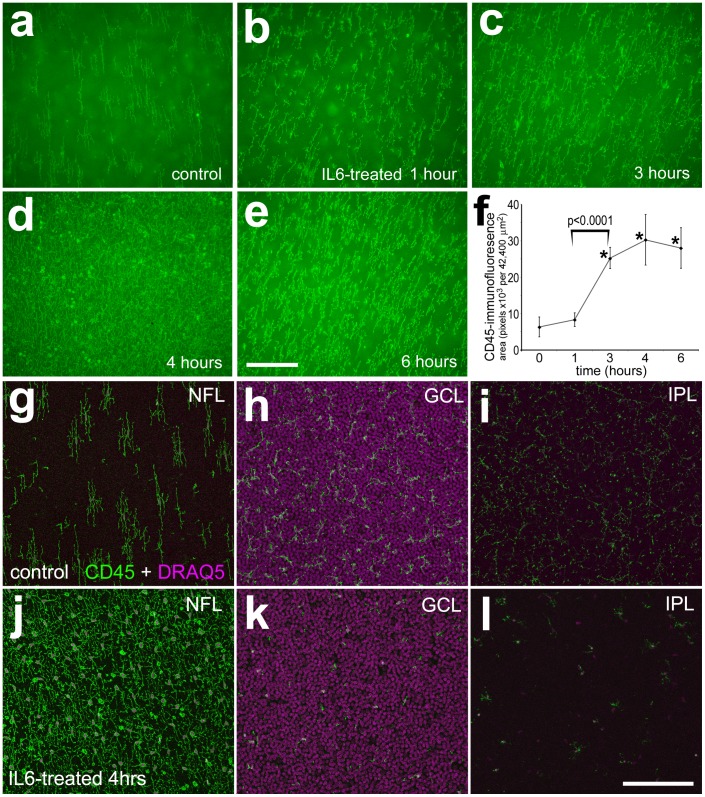
IL6 stimulates the rapid migration of microglia to vitread surface of the retinas.Retinas were obtained from eyes injected with vehicle (control; a, g–i) or IL6 at 1 (b), 3 (c), 4 (d, j–l) and 6 (e) hours after treatment. Whole-mount preparations of the retina were labeled with DRAQ5 (magenta; g–i) and antibodies to CD45 (a–e and g–l). The scale bar (50 µm) in panel e applies to a–e, and the bar in l applies to g–l. The histogram in panel f illustrates the mean (±SD) area for CD45-immunofluorescence above threshold, per field of view (42,400 µm2), at 1, 3, 4 and 6 hours after treatment. Image Pro 6.2 was used to measure the total area for pixel intensities >68 (0 = black, 255 = saturated green) per field of view, as described in the Methods. Significance of difference was determined by using a one-way ANOVA (p<0.0001). Significance of difference between control and treated groups (*p<0.0001), and between treatment time-points (bracket and p-values) was determined by using a post-hoc two-tailed Student’s t-test. Abbreviations: ONL – outer nuclear layer, INL – inner nuclear layer, IPL – inner plexiform layer, GCL – ganglion cell layer, NFL – nerve fiber layer.